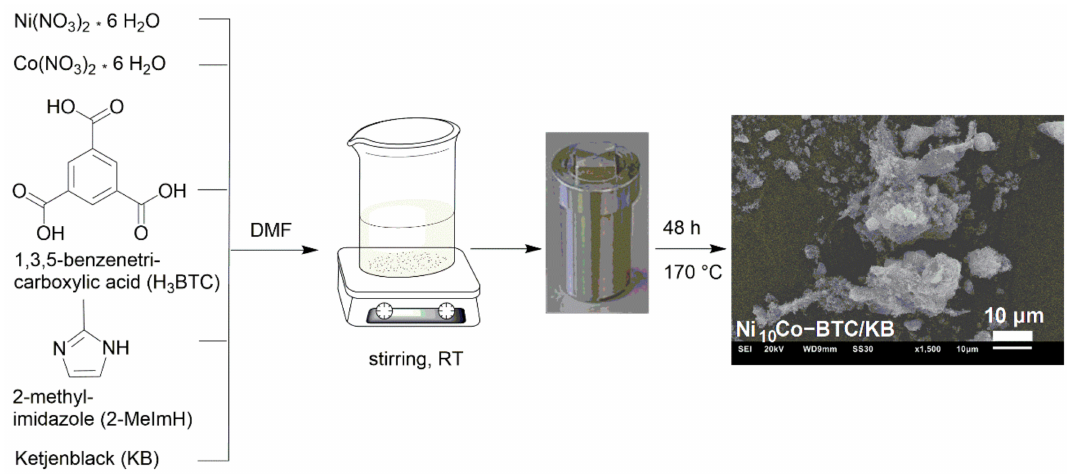
Figure 1. Schematic illustration of the Ni 10 Co-BTC/KB composite synthesis.